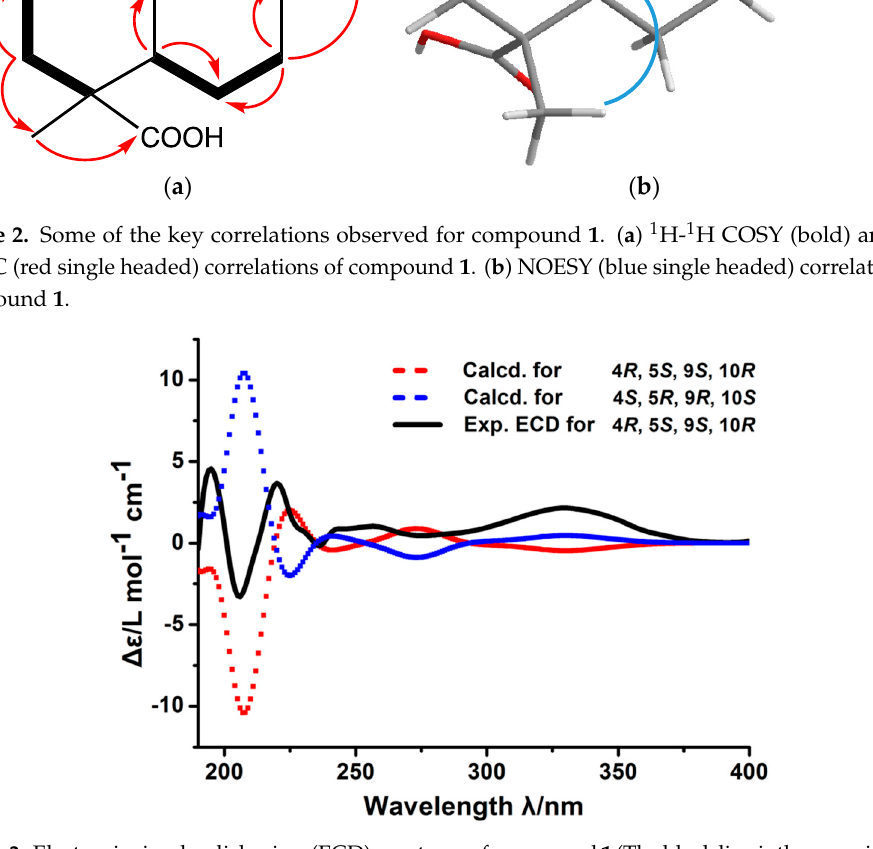
Figure 3. Electronic circular dichroism (ECD) spectrum of compound 1 (The black line is the experimental ECD spectrum, red and blue dashed lines are calculated ECD spectra.).